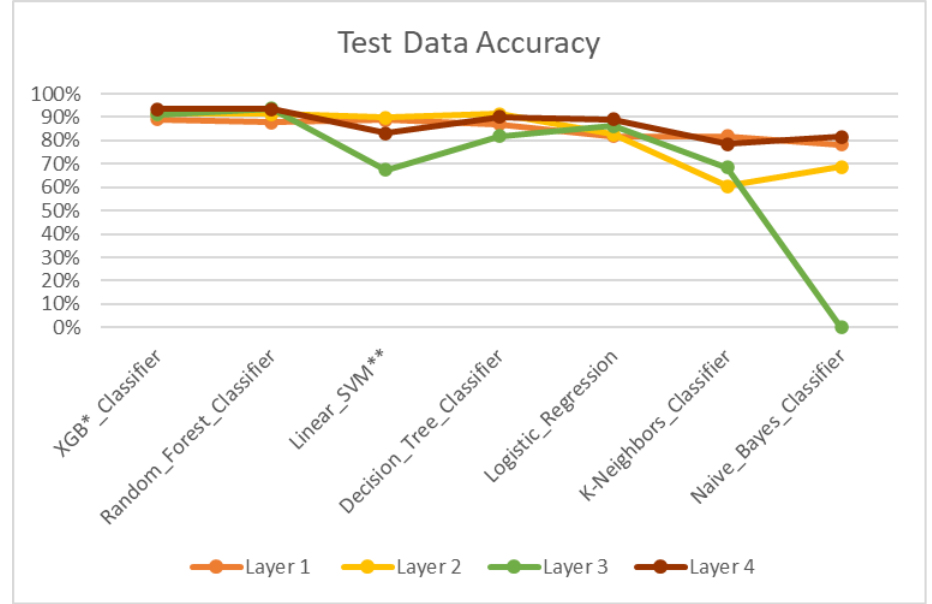
Figure 9. Test data—accuracy. * XGB—eXtreme Gradient Boosting. ** SVM—Support Vector